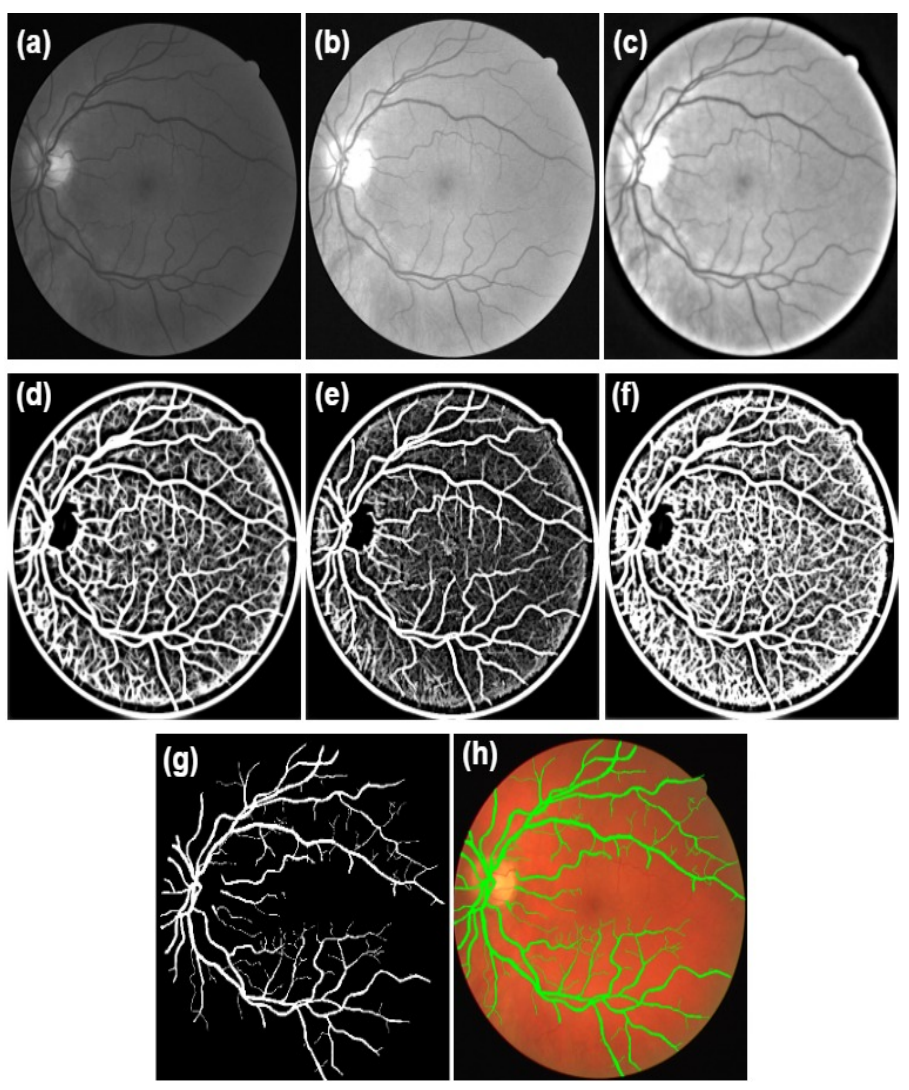
Figure 3. The proposed trainable filters algorithm outputs: ( a ) the normalized green channel; ( b ) the CLAHE output; ( c ) the DT-CWT output; ( d ) the output of the symmetric filter; ( e ) the output of the asymmetric filter; ( f ) the combination of the symmetric filter and asymmetric filter; ( g ) the final segmented image from the edge detection stage after applying thresholding; ( h ) the overlapped automated segmented image with the original retinal